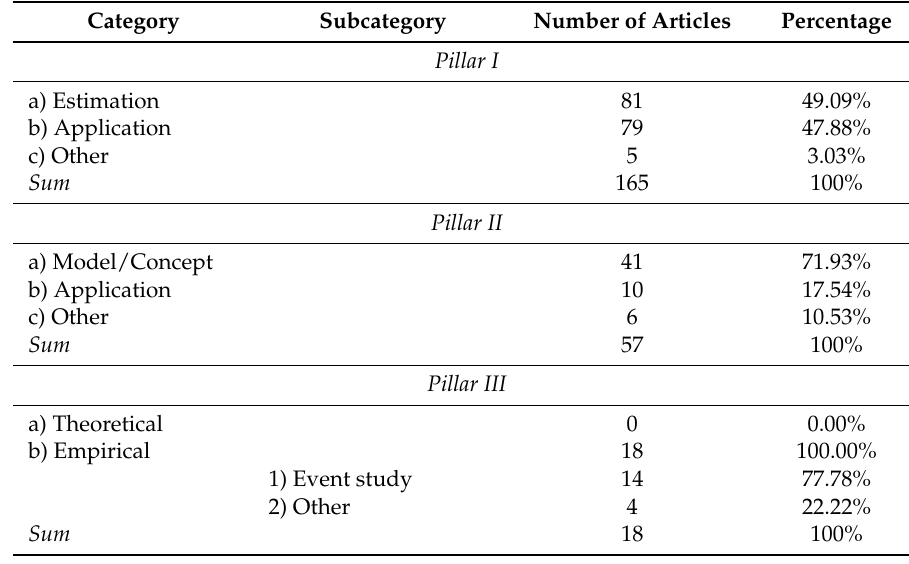
Table 1. Dominant themes among Pillar